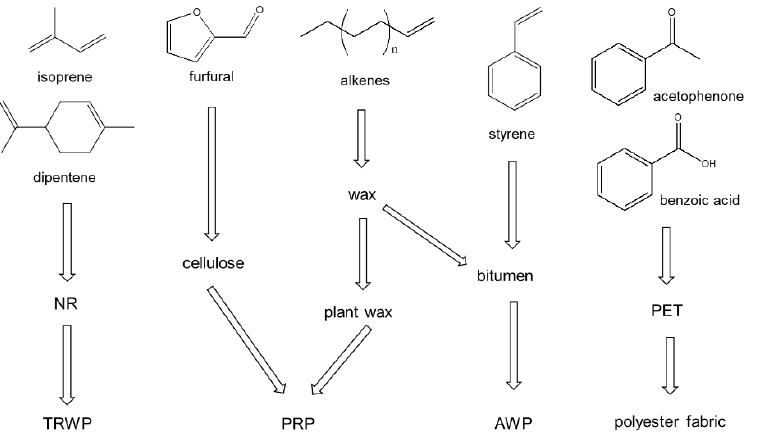
Figure 6. Sources of the principal pyrolysis products obtained from the PM 2.5 samples.